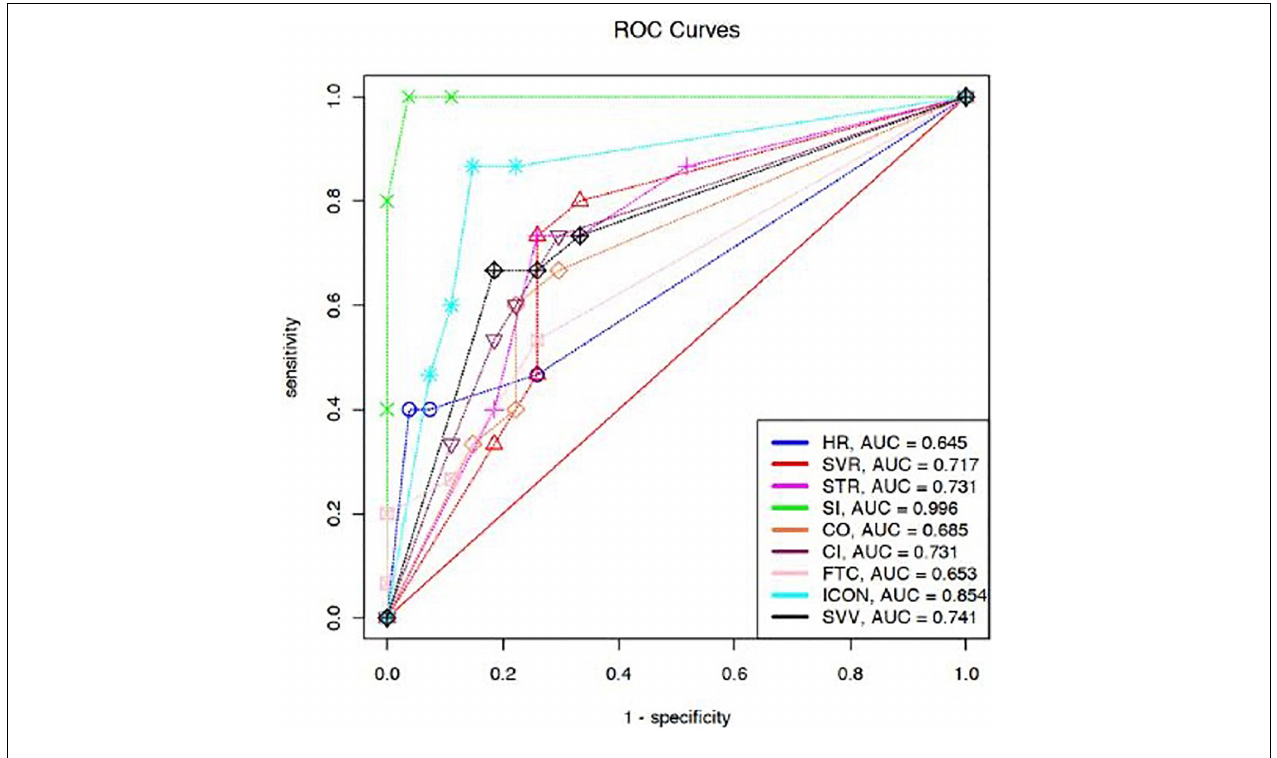
FIGURE 3 | Comparison of AUCs for prediction of FR after fluid expansion. (cid:49) HR [0.64 (95% CI 0.55–0.72)], (cid:49) SVR [0.71 (95% CI 0.62–0.79)], (cid:49) SVV [0.74 (95% CI 0.65–0.82)], (cid:49) STR [0.73 (95% CI 0.64–0.81)], (cid:49) SI [0.99 (95% CI 0.97–1)], (cid:49) CO [0.68 (95% CI 0.59–0.76)], (cid:49) CI [0.73 (95% CI 0.64–0.81)], (cid:49) FTC [0.65 (95% CI 0.56–0.73)], and (cid:49) ICON [0.85 (95% CI 0.78–0.91)]. HR, heart rate; RR, respiratory rate; SBP, systolic blood pressure; DBP, diastolic blood pressure; MAP, mean arterial pressure; SV, stroke volume; SI, stroke index; CO, cardiac output; CI, cardiac index; SVV, stroke volume variation; FTC, corrected flow time; TFC, thoracic fluid content; SVR, systemic vascular resistance; STR, systolic time ratio; ICON, index of contractility; VIC, variation of index of contractility; (cid:49) , percentage